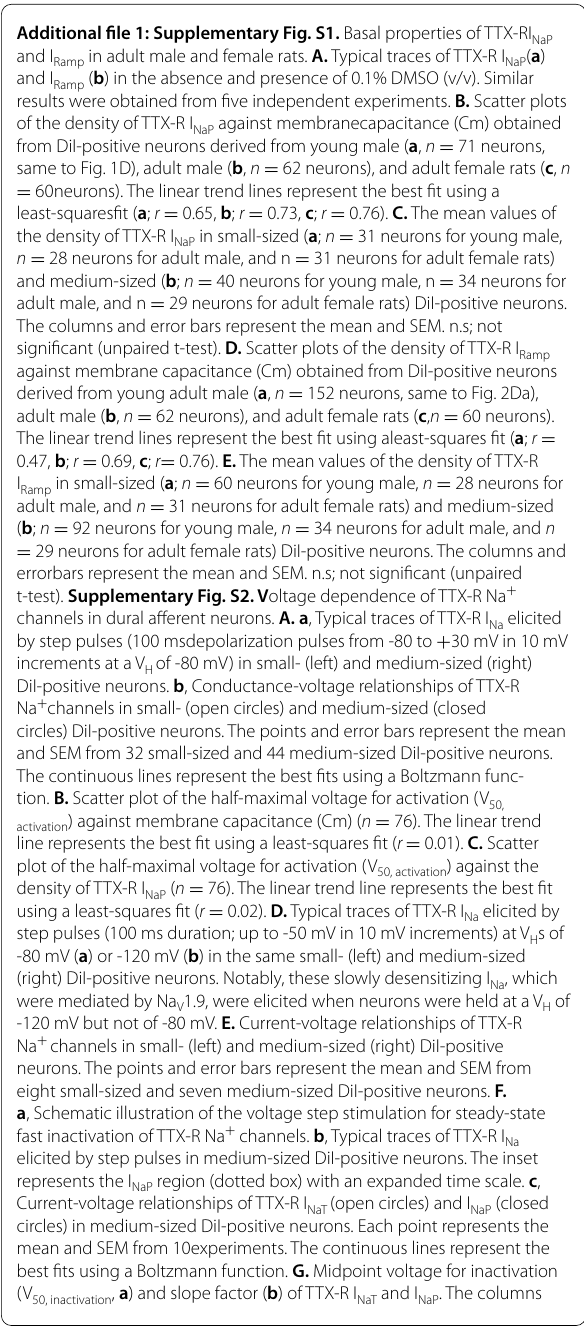
and error bars represent the mean and SEM from 10 medium‑sized DiI‑positive neurons. n.s; not significant (paired t‑test). Supplementary Fig. S3. Kinetic parameters for the development of inactivation of TTX‑R Na + channels in dural afferent neurons. A. Schematic illustration of the two‑pulse protocols used for the development of inactivation of TTX‑R Na + channels. TTX‑R I Na were induced by the conditioning prepulse (P 1 :